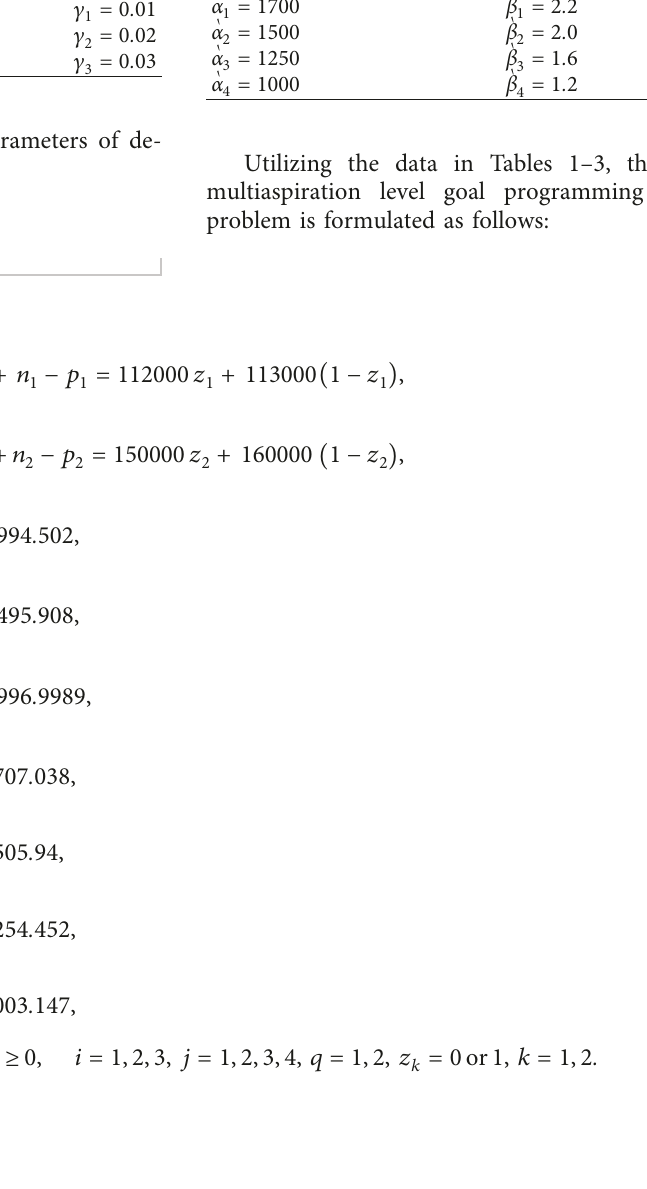
Table 1: Transportation time cost t